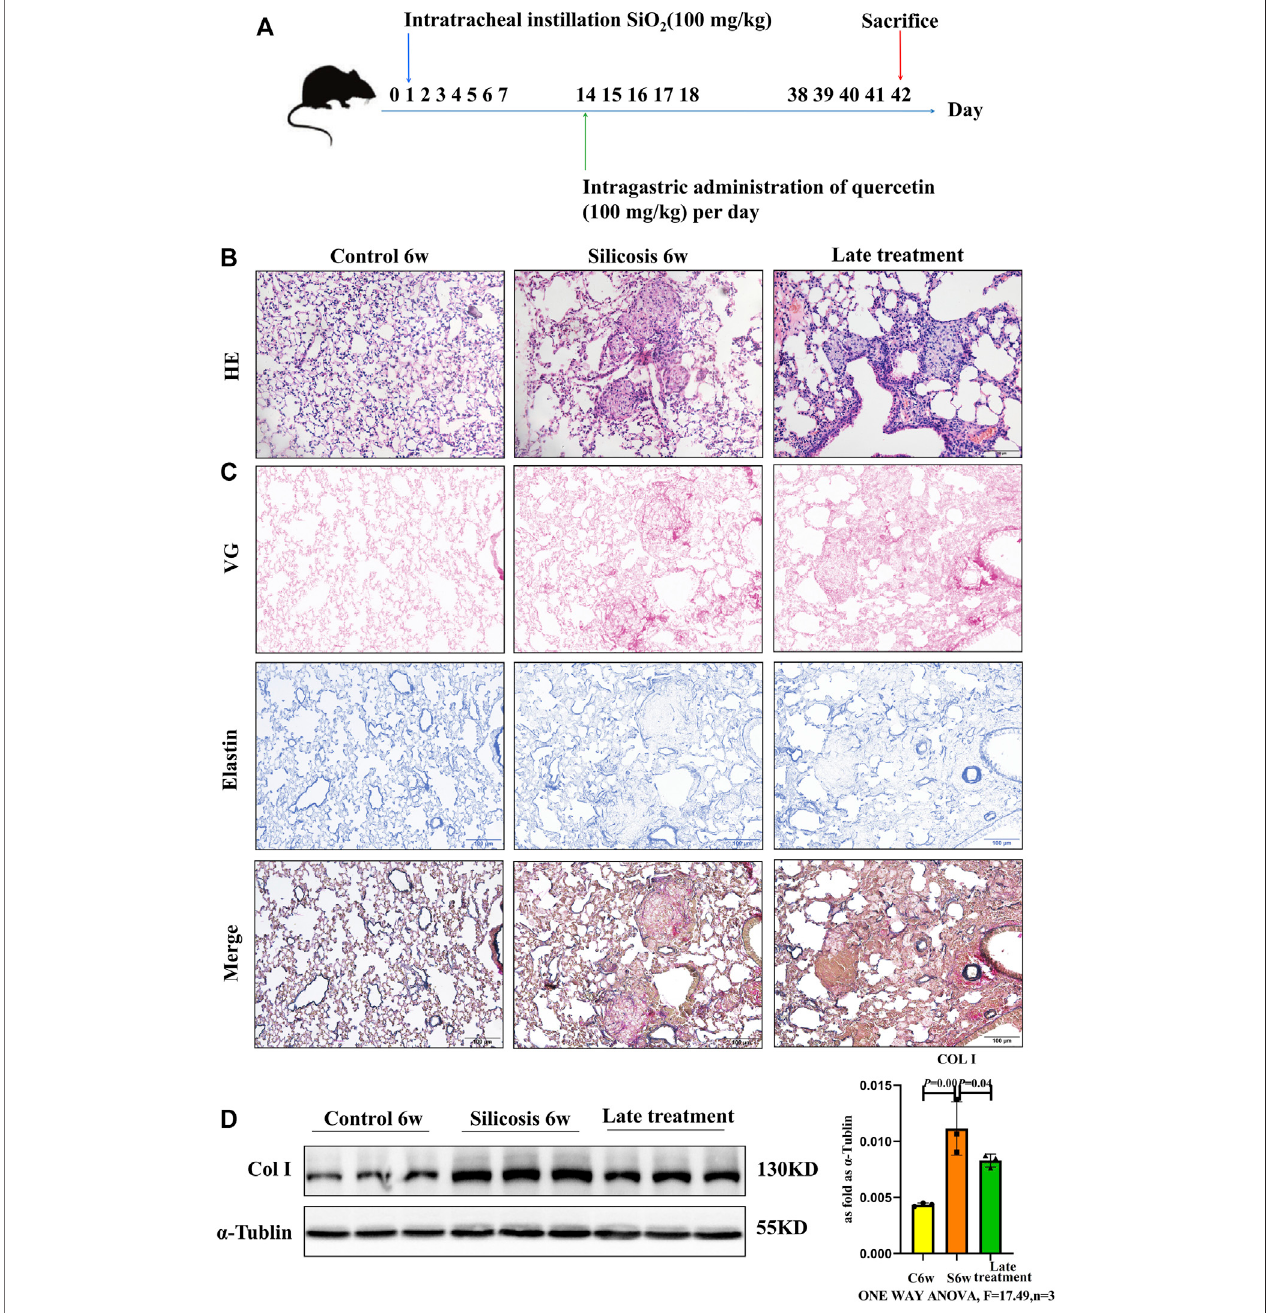
FIGURE 2 | Quercetin attenuates lung injury in a late therapeutic silicosis model. (A) Schematic of quercetin administration in a late therapeutic silicosis model. (B) Representative micrographs showing lung injury by HE staining. (C) VG and elastin staining of lung tissue sections. (D) Col I expression by western blot. Data are presented as the mean ± SD. n = 3 per